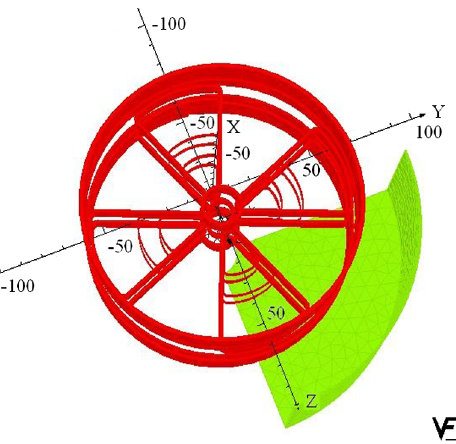
FIG. 2. TOSCA model of superconducting coil cyclotron (SCCCYC) and magnetic shield.